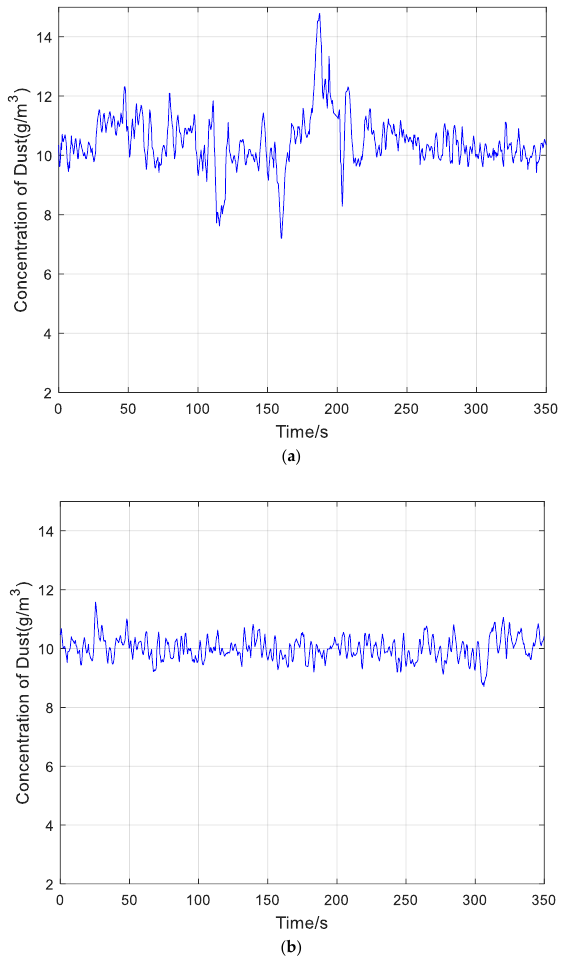
Figure 15. ( a ) Dust concentration controlled with PID controller; ( b ) dust concentration controlled with fuzzy-SAE controller.